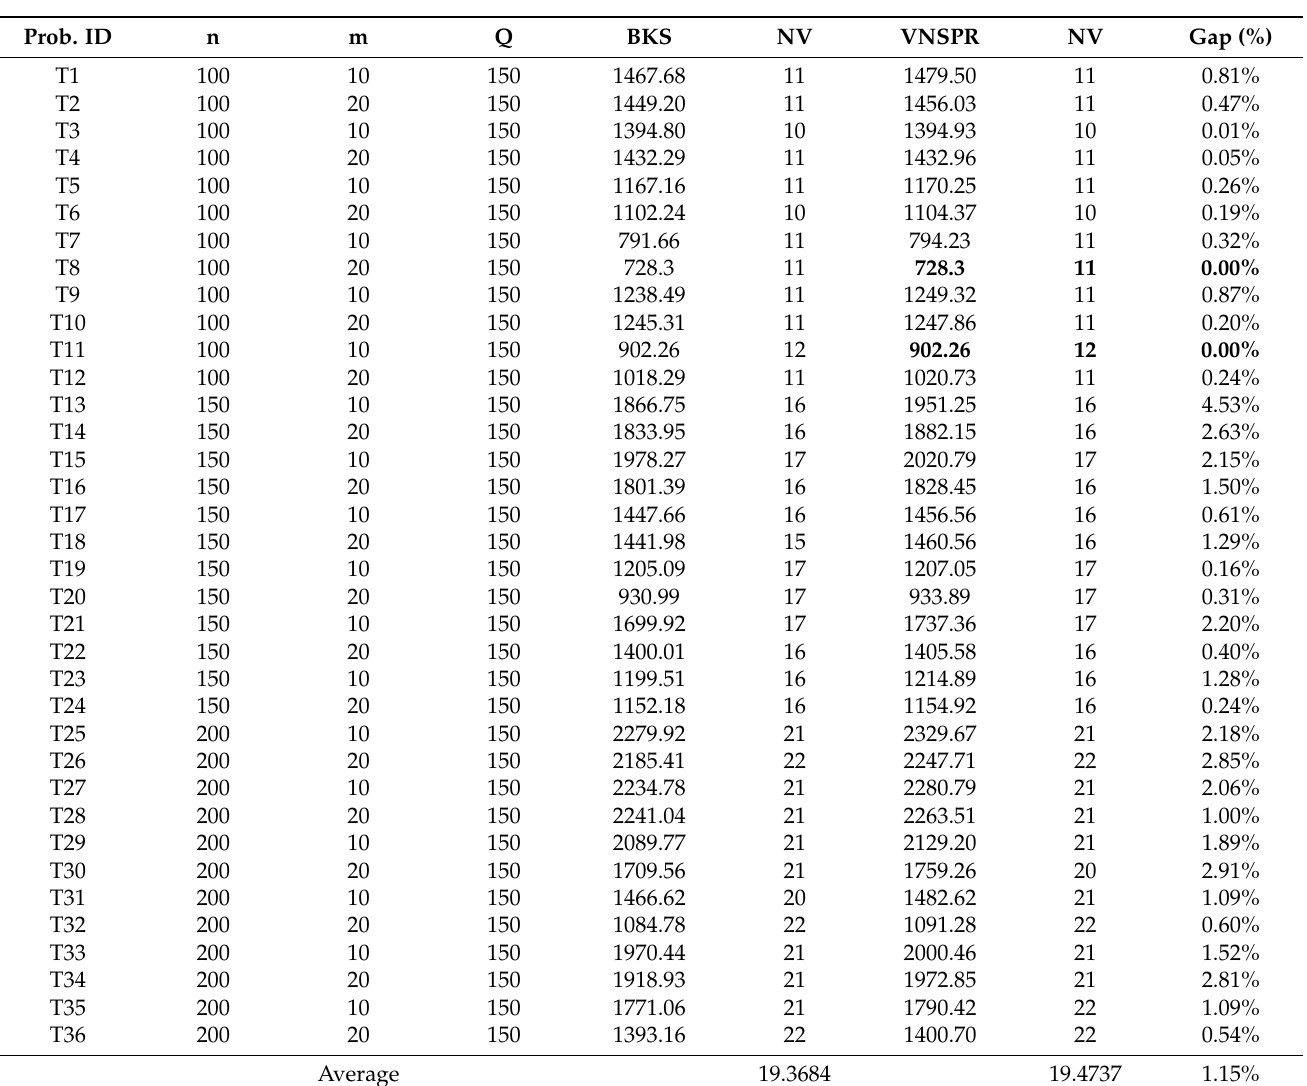
Table 8. Computational results LRP with time windows for Tuzun and Burke’s